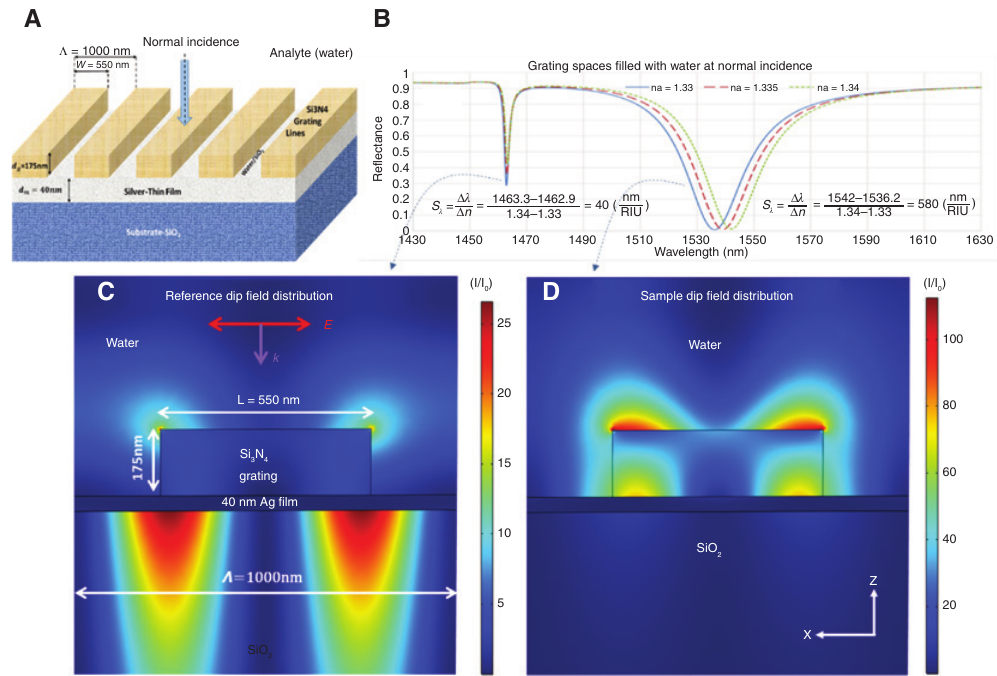
Figure 9: Field enhancement upon double plasmon excitation using thin dielectric grating and thin metal film. (A) Schematic of thin dielectric grating on top of a thin metal film configuration. (B) Reflectivity spectrum at normal incidence exhibiting analyte and substrates modes (SPR and LRSPR). (C) and (D) Electric field intensity distribution at the wavelengths of the two excited ESP modes. It should be noted that the field distribution for this geometry presented in [59, 60] is correct but the scale had an error in these